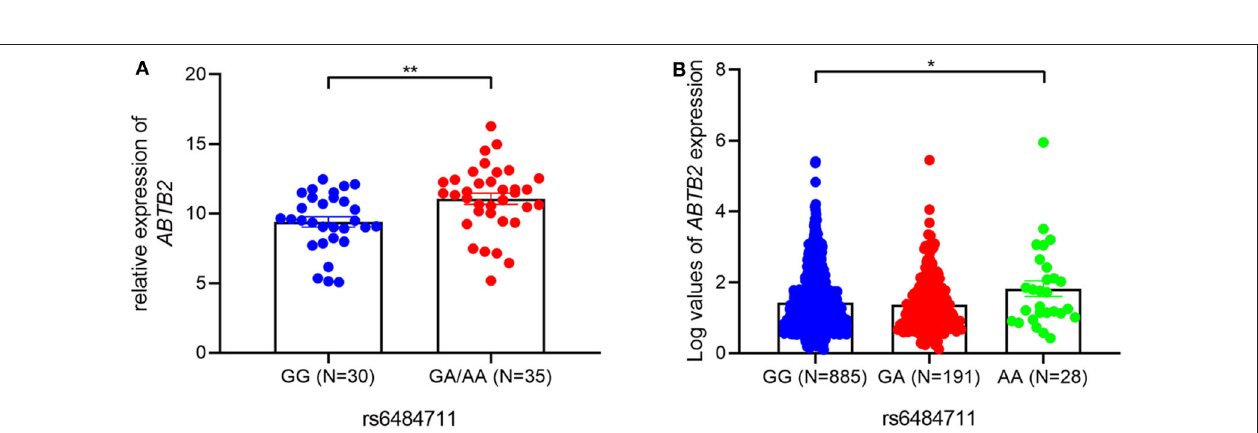
FIGURE 2 | The eQTL analyses of rs6484711. The associations between rs6484711 genotypes and ABTB2 levels in 65 BC tissues (A) and 1104 samples in TCGA (B) . ABTB2 mRNA levels were relative to GAPDH using qRT-PCR in our samples and were represented by a log transformation of fragments per kilobase of exon per million fragments mapped (FPKM) value in TCGA data. The rs6484711[GA] and [AA] genotypes had significantly higher ABTB2 mRNA than the rs6484711[GG] genotype (* P = 0.030, ** P = 0.004). Results were shown as the means ± S.D., and P -value was from two-sided t